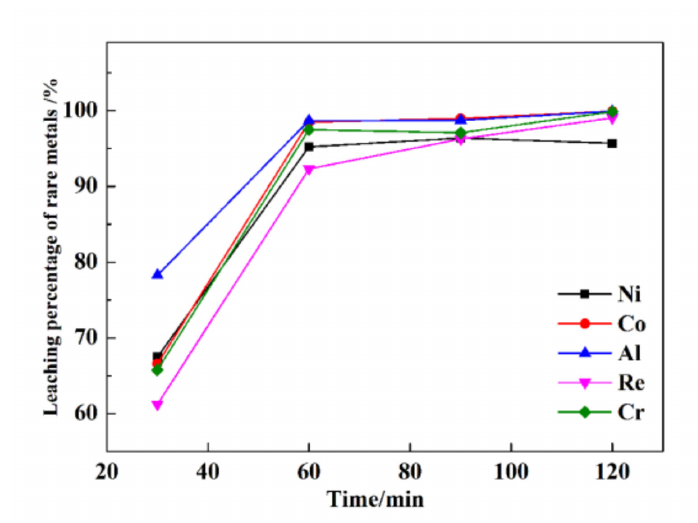
Figure 5. The leaching percentages of rare metals under various times.